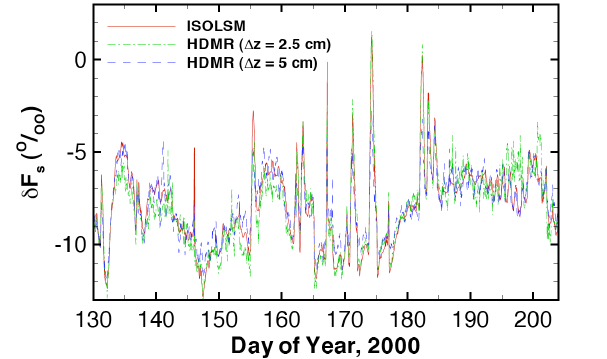
Fig. 1. Simulated δ sw in four soil layers over a twenty-day period in Figure 1. Simulated δ sw in four soil layers over a twenty-day period in June 2000. Spikes 6 June 2000. Spikes in δ sw in the top 2.5cm result from soil evapora- in δ sw in the top 2.5 cm result from soil evaporation, precipitation, and wicking from 7 tion, precipitation, and wicking from lower soil layers. lower soil layers. 8